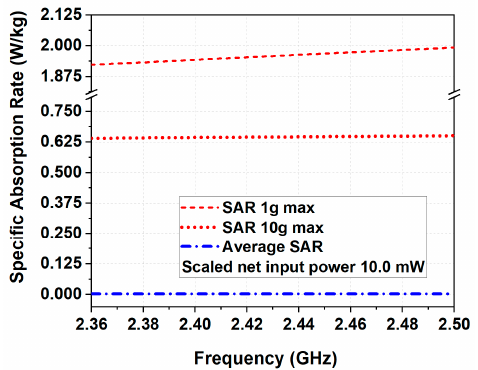
Figure 9. Simulated 1 g, 10 g, and averaged SAR for the proposed antenna mounted on the surface of Phantom 2.